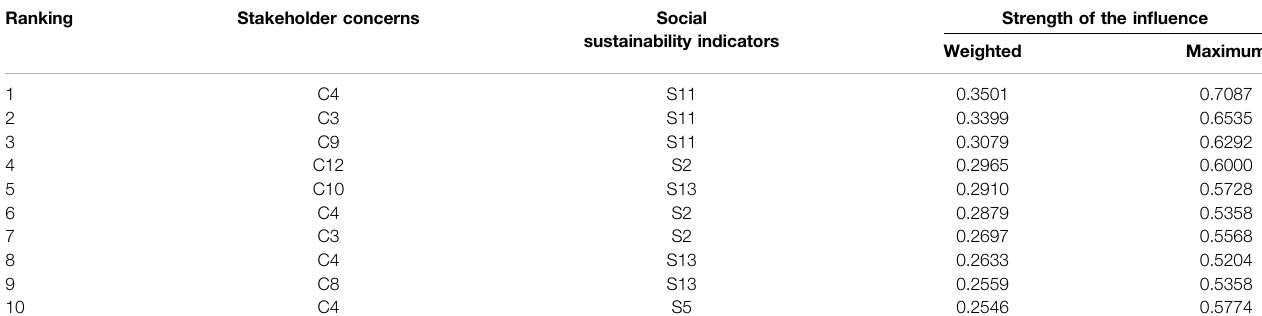
TABLE 5 | Ranking of the in fl uences according to factor strength. Ranking